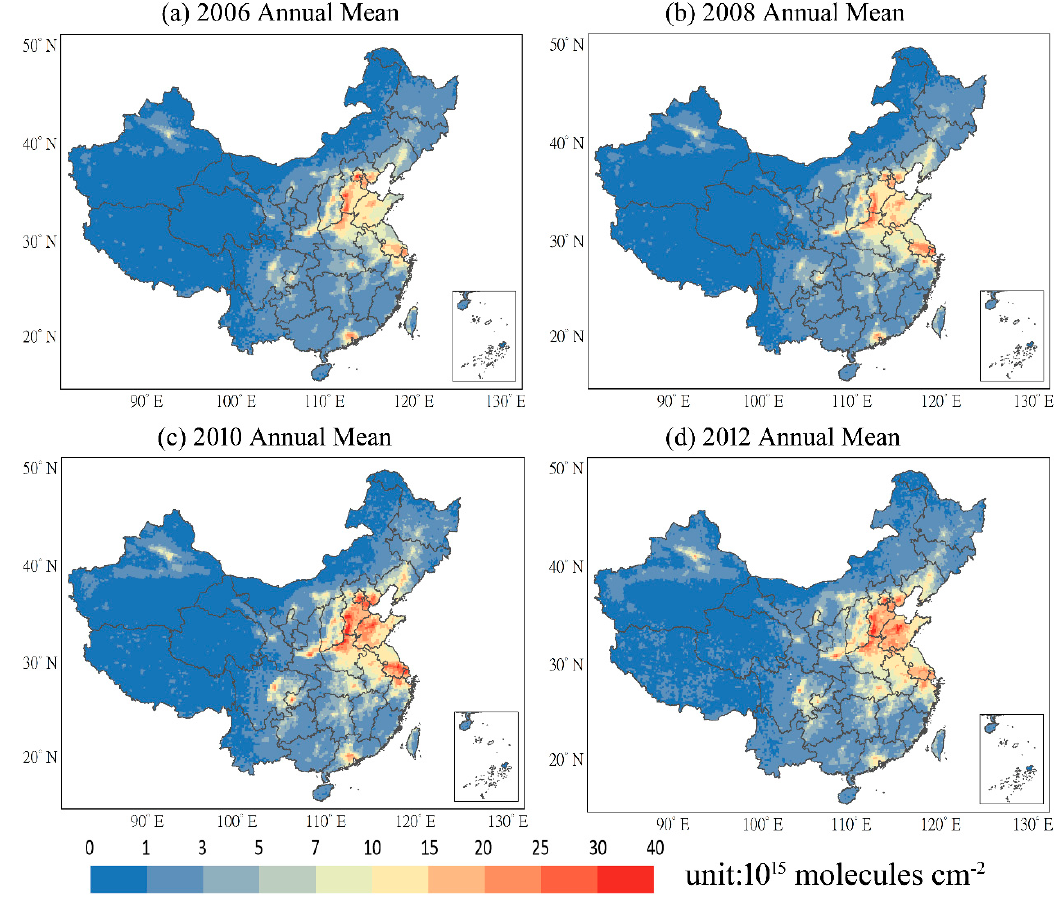
Figure 1. Spatial distribution of annual mean tropospheric NO 2 over China in 2006, 2008, 2010 and 2012.